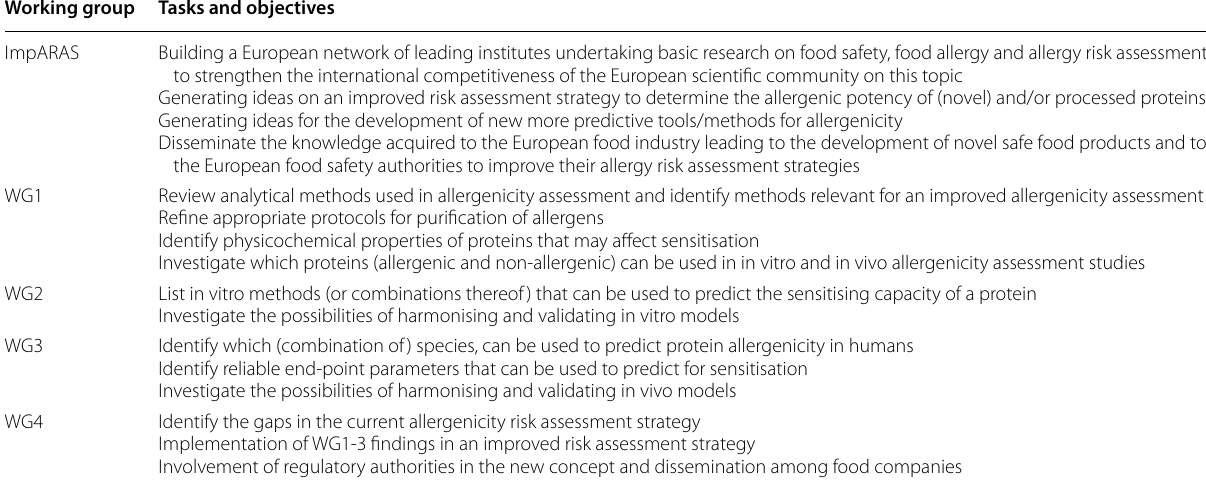
Table 1 Objectives of ImpARAS and tasks assigned to the 4 ImpARAS working groups Working group Tasks and objectives